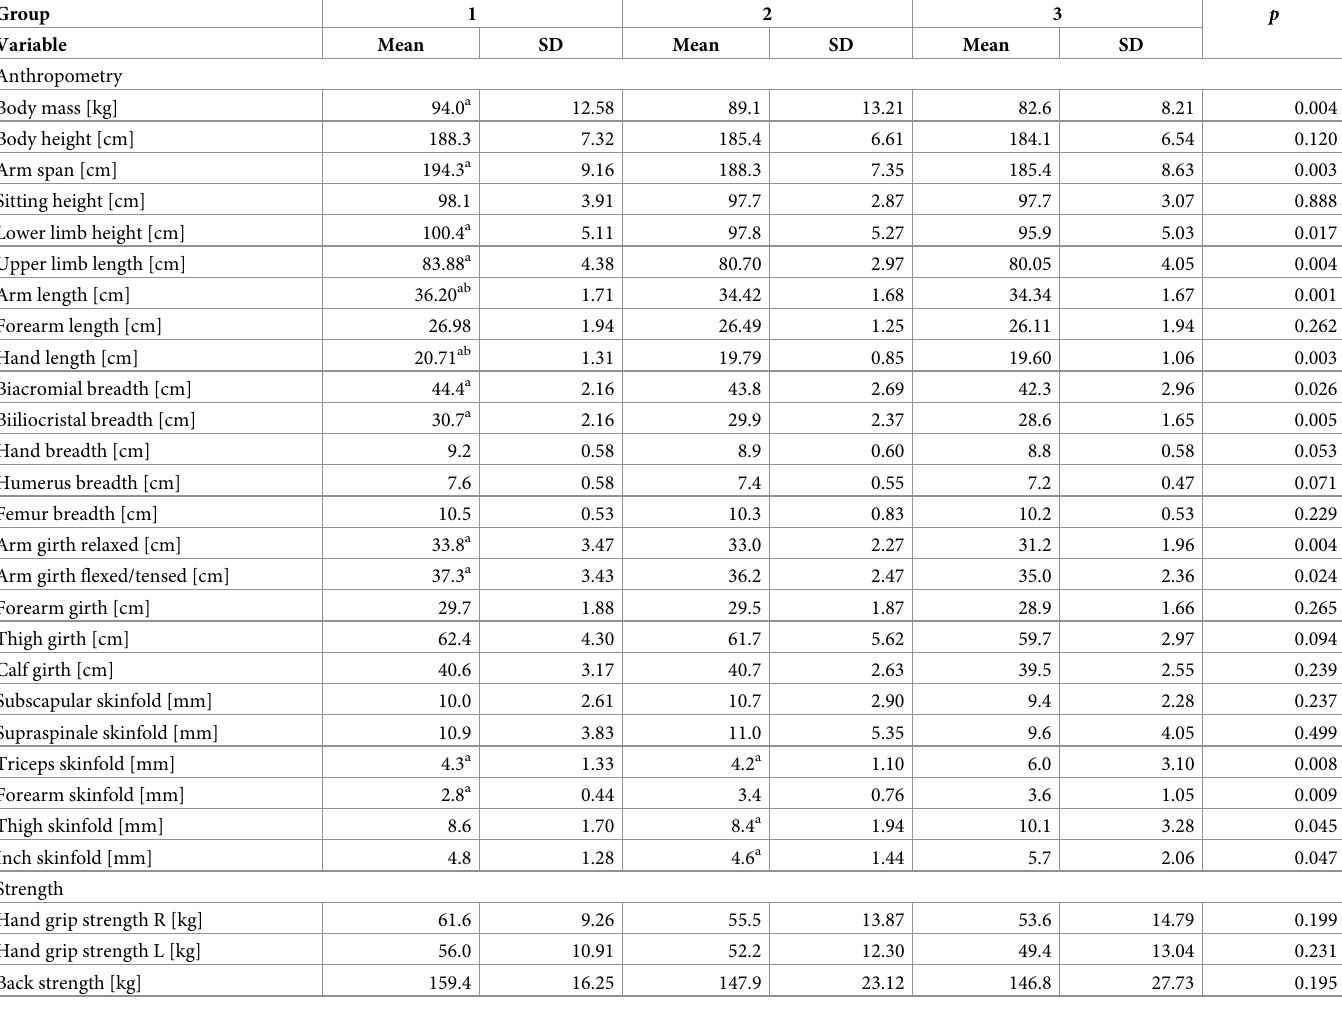
Table 1. Statistical characteristics and inter-group differences of the morphological traits in handball players (SD–standard deviation).